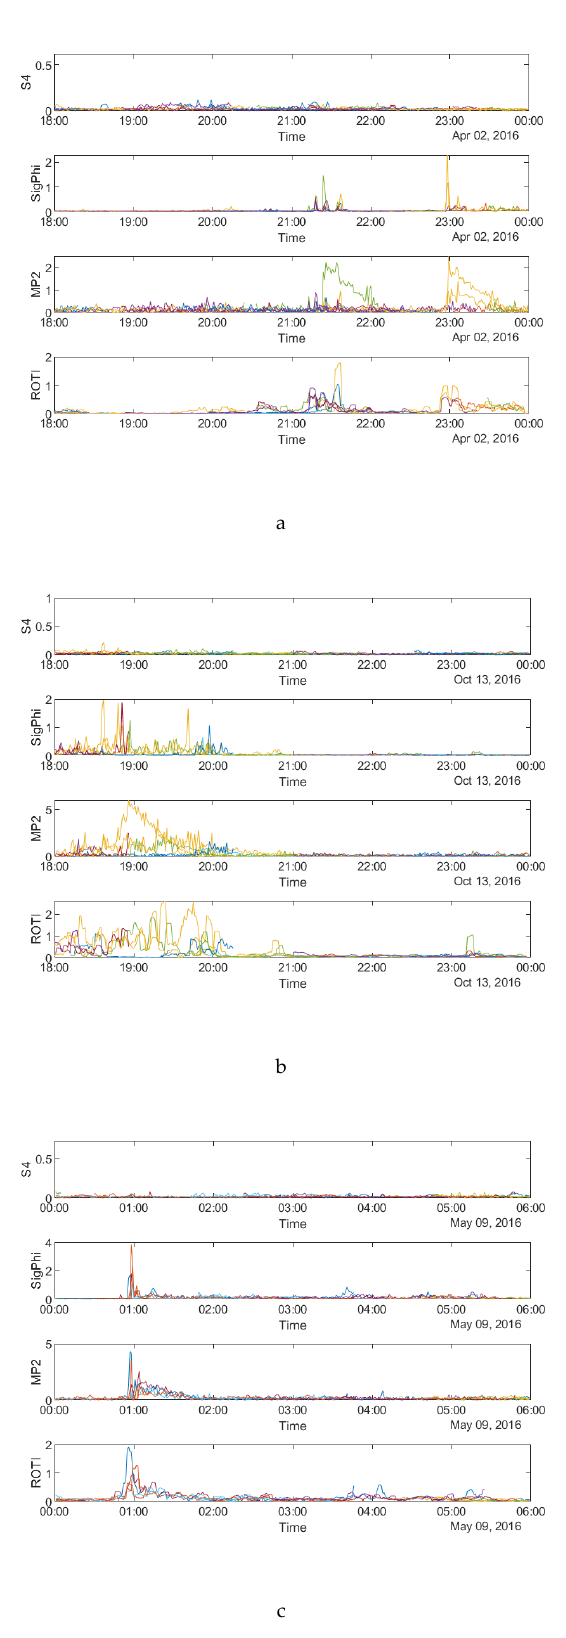
Figure 11. Time series plots of four parameters at SNA0P station: ( a ) during 18:00:00–24:00:00 UTC on 2 April 2016; ( b ) during 18:00:00–24:00:00 UTC on 13 October 2016; ( c ) during 00:00:00–06:00:00 UTC